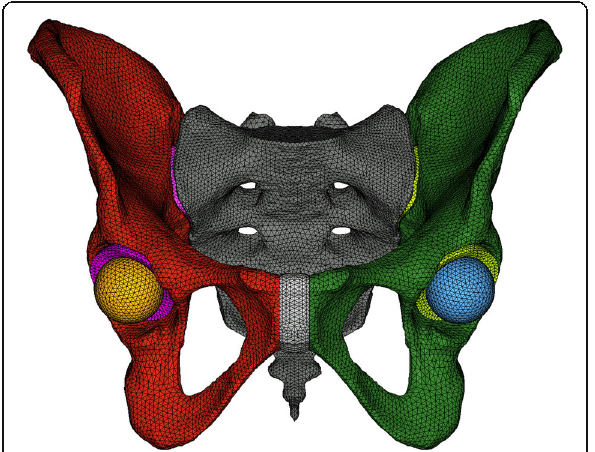
Fig. 1 Geometries from the FE model of the non-fractured